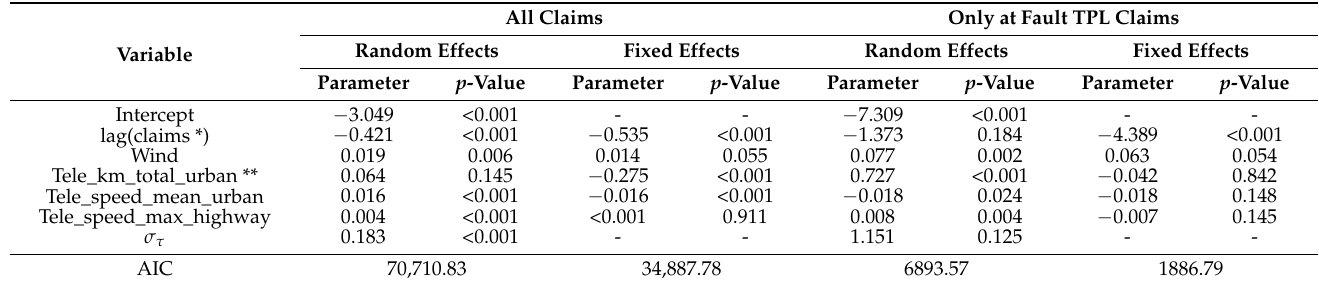
Table A7. Cross-table with the parameter estimates of random effects and fixed-effects Poisson panel data models, with p -values. for the total number of claims (left) and at-fault third party liability (TPL) claims (right) per month and per insured based on the eight observed months in 2018 and 2019, i.e., month 5 is